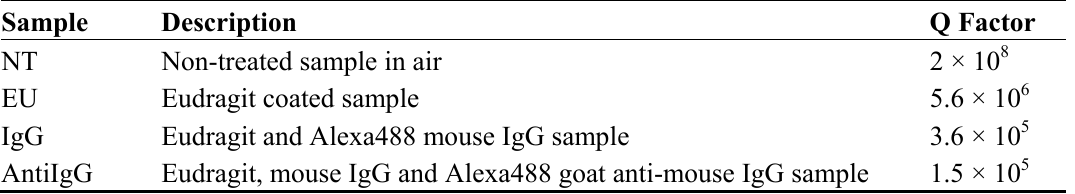
Table 1. Description of the samples used for optical characterization and their Q factor.